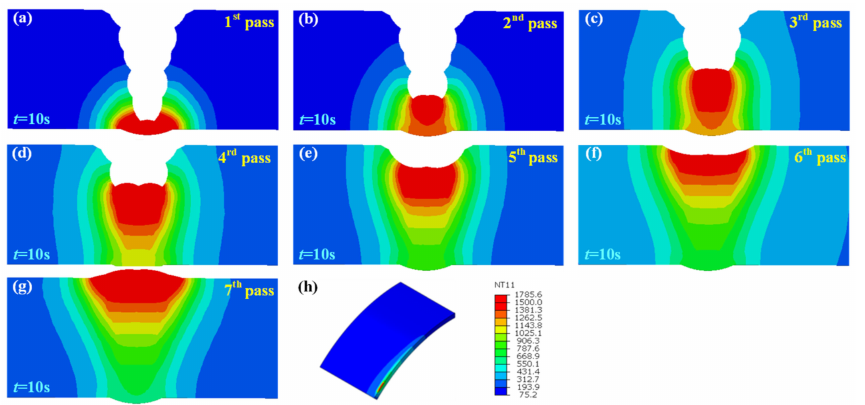
Figure 7. Joint temperature field with 0 mm butt gap: ( a – g ) temperature distribution of each pass, ( h ) isometric view of temperature field.